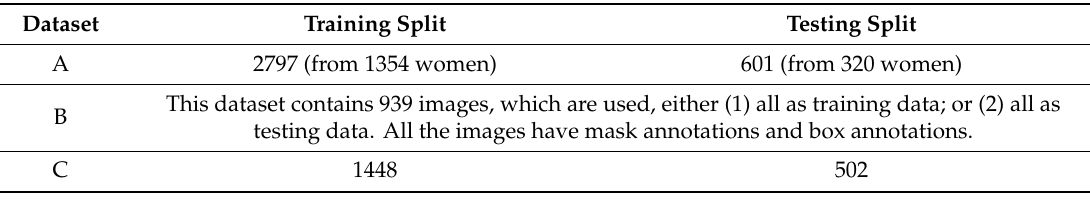
Table 1. Quantitative details of Datasets A, B, and C.